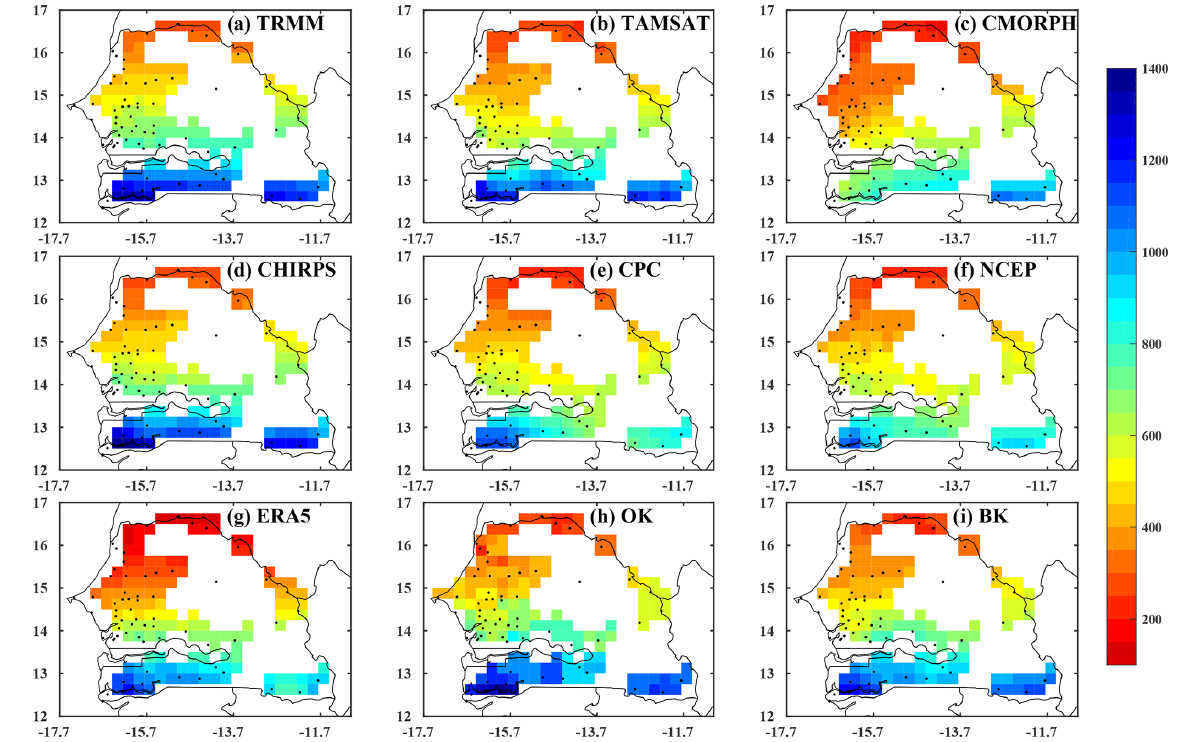
Figure 2. Spatial distribution of average seasonal rainfall from June to October for the overlap period between datasets (1998–2010, in mm) using (a) TRMM, (b) TAMSAT, (c) CMORPH, (d) CHIRPS, (e) CPC, (f) NCEP, (g) ERA5, (h) OK, and (i) BK. The black dots represent the stations used. Details of the datasets are provided in Table 1.